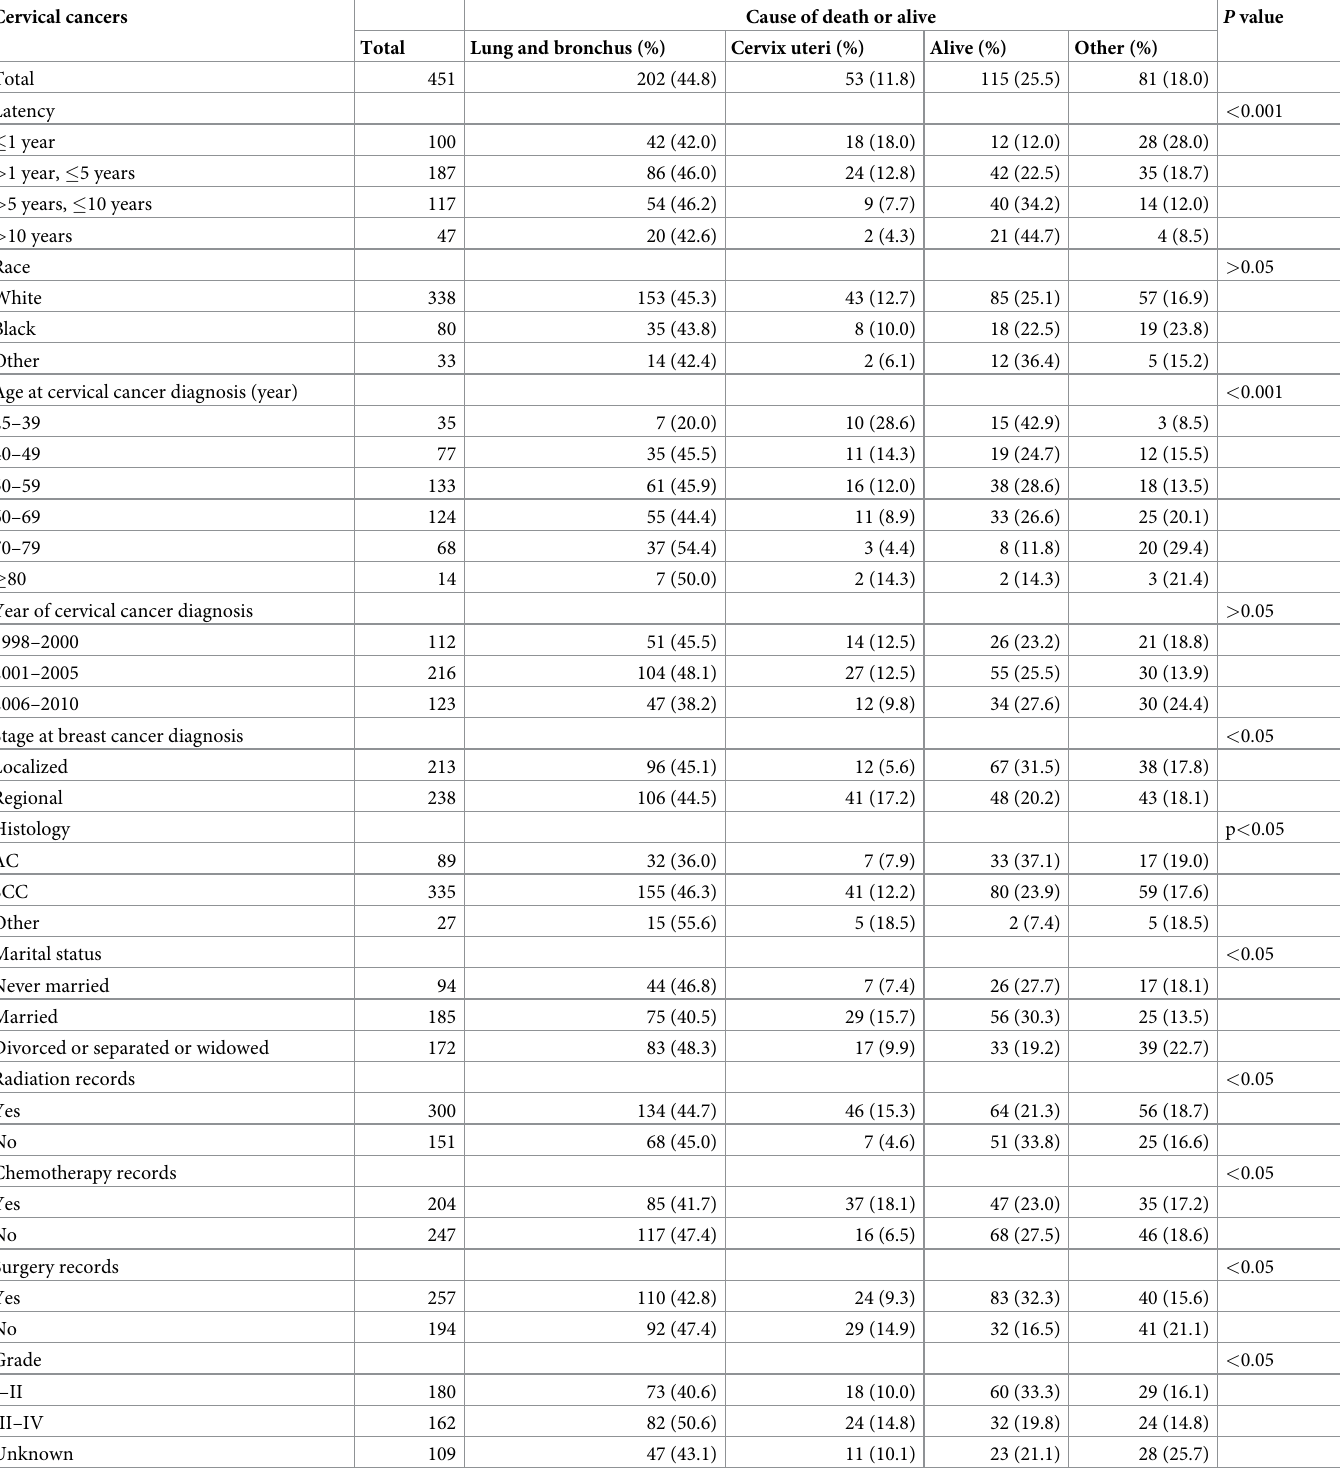
Table 3. Impact of demographic and clinical features of cervical cancer on death in patients with CC-NSCLC. Cervical